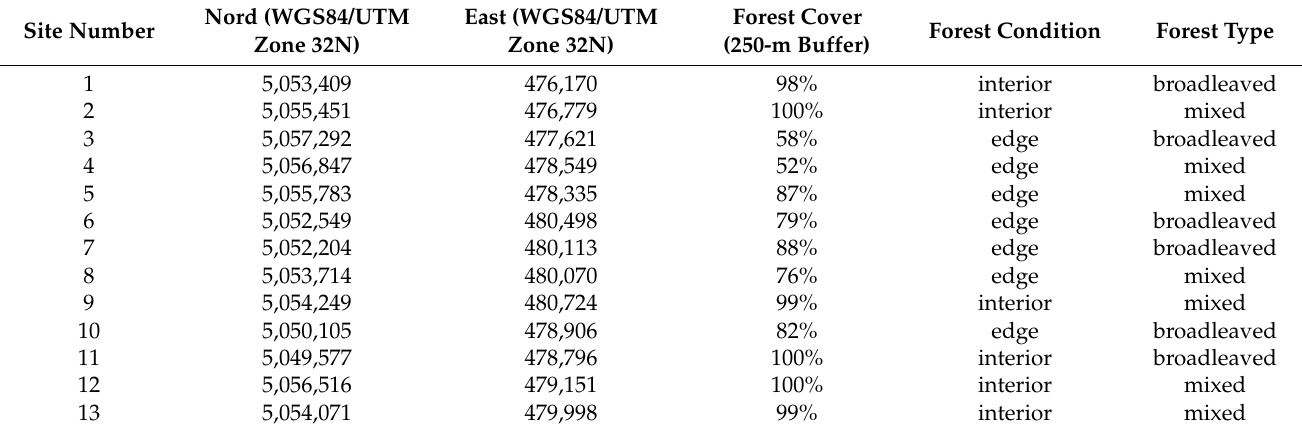
Table 1. Location of the sampling sites in which the group of three traps was triggered with different baits. The forest covers in a buffer of 250 m around the sampling site used to define the forest conditions (interior condition: forest cover >90%) and forest type.